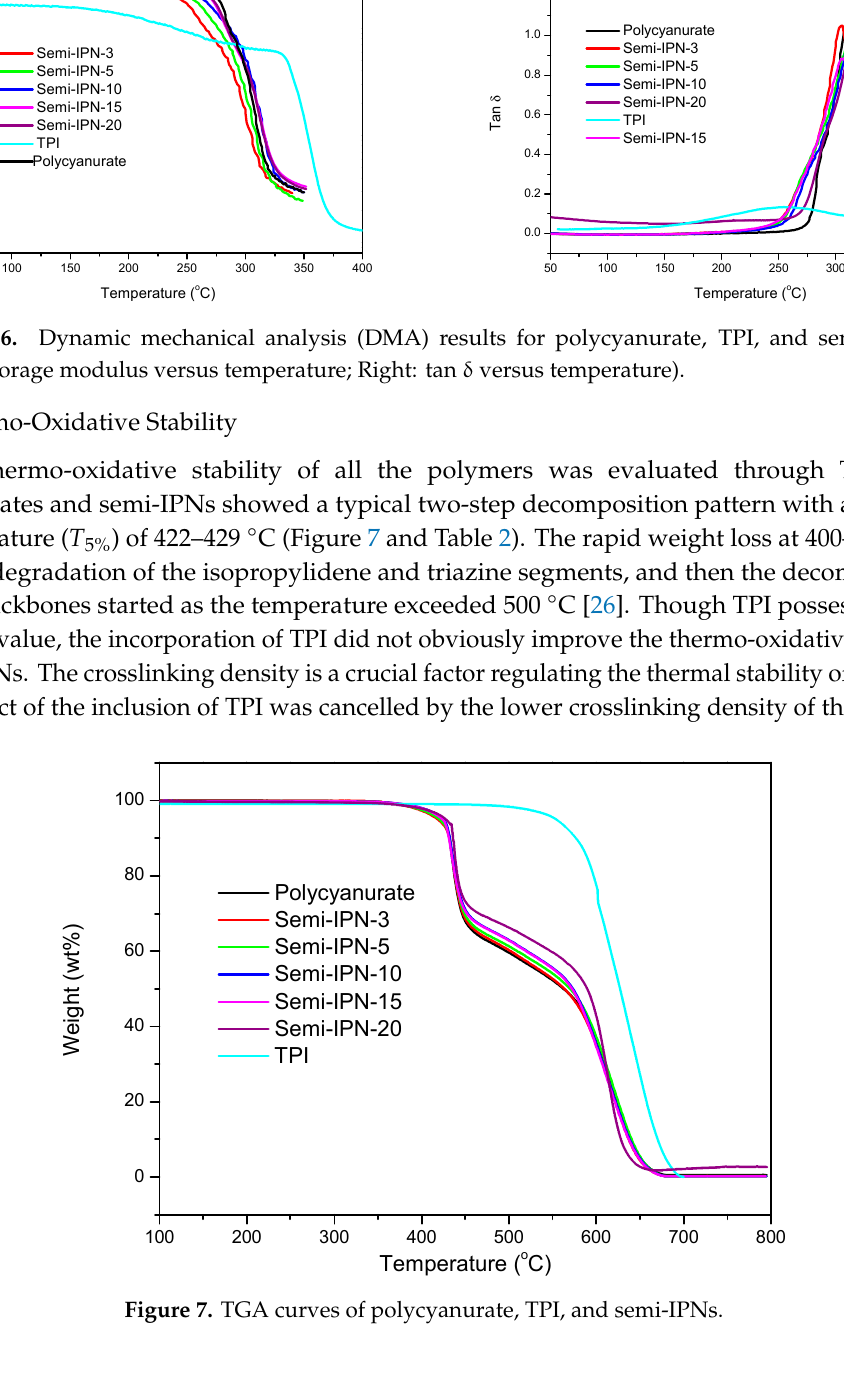
Table 2. Thermal and dielectric properties of polycyanurate, TPI, and semi-IPNs.